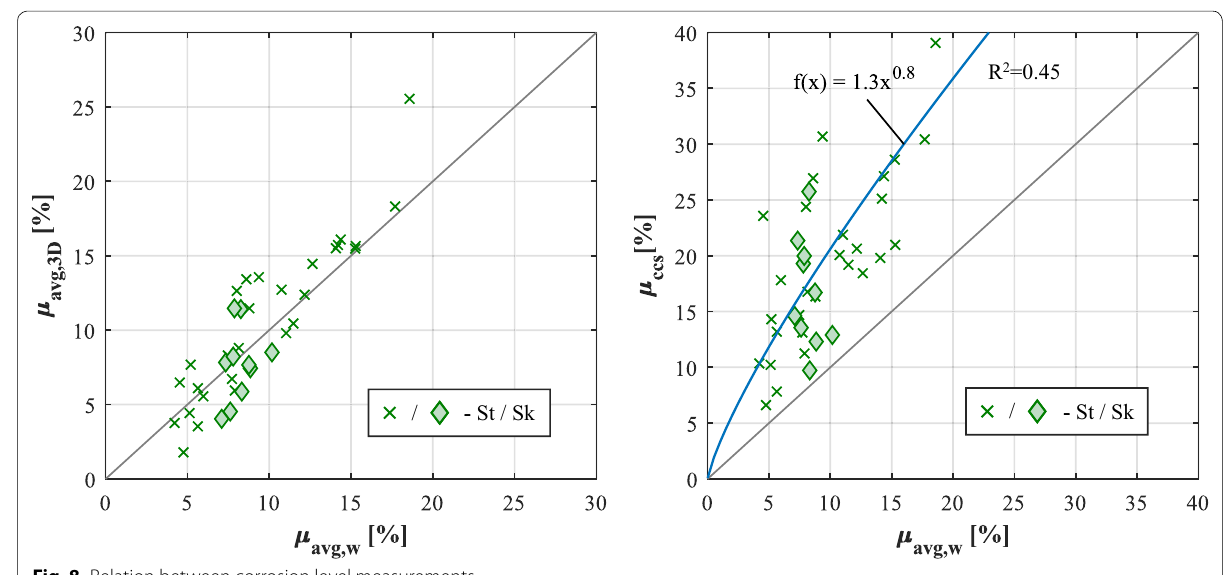
Fig. 8 Relation between corrosion level